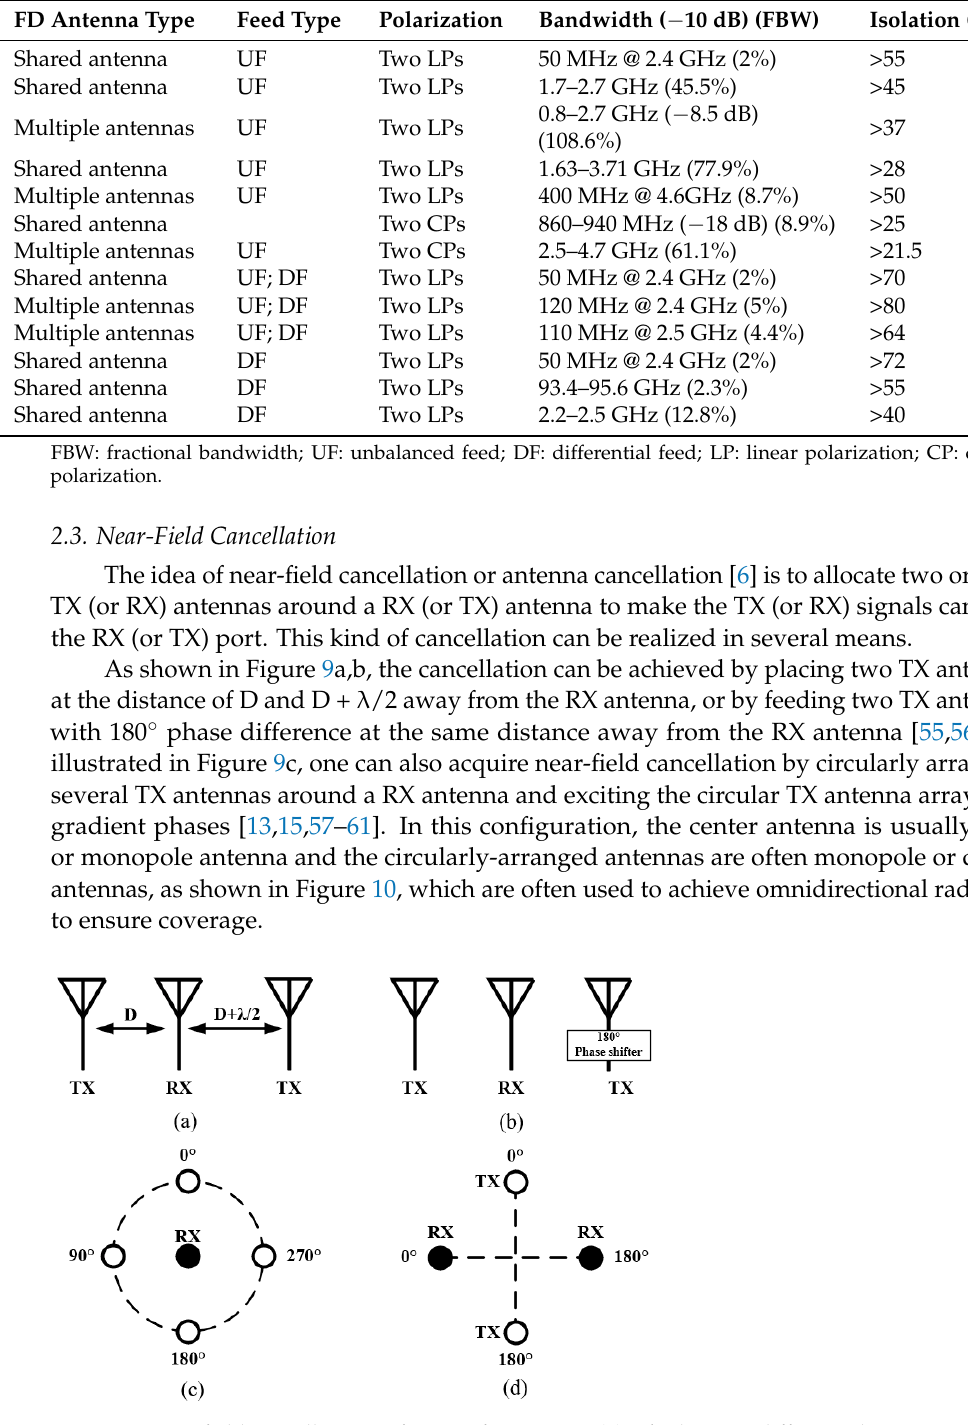
Figure 9. Near-field cancellation in four configurations. ( a ) λ /2 distance difference between transmitting (TX) antennas. ( b ) 180 ◦ phase difference between TXs. ( c ) Circular TX array with gradient phases. ( d ) TX and receiving (RX) antenna pairs with differential feeding.